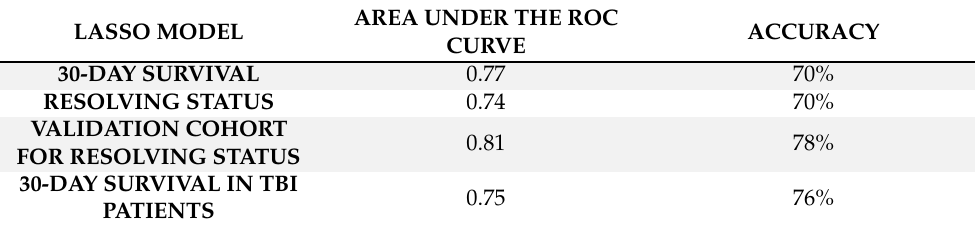
Table 2. LASSO model AUC and accuracies for each group including validation cohort. AREA UNDER THE ROC LASSO MODEL ACCURACY CURVE 30-DAY SURVIVAL